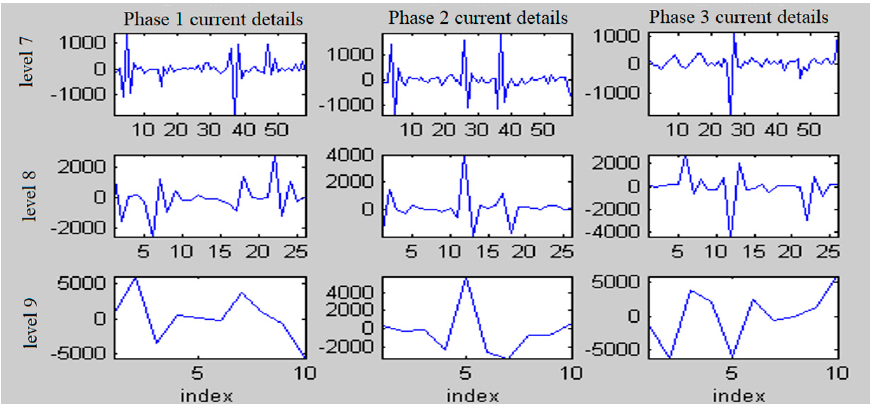
Figure 17. Vectors of approximations for currents, levels 7–9, first case study.